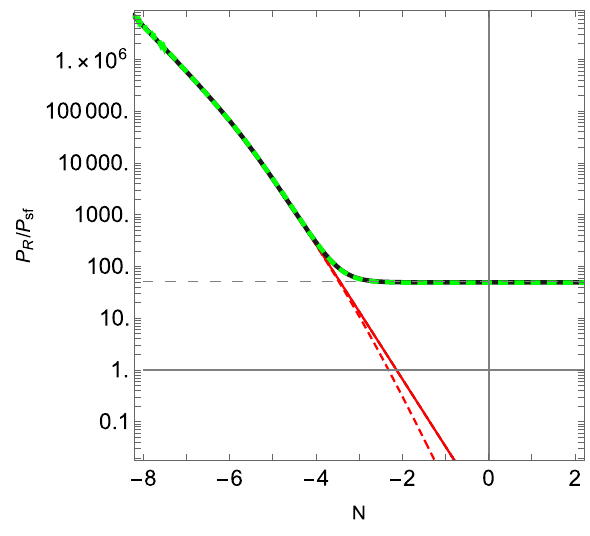
Fig. 4 Numerical calculations in single-field effective theories with modified dispersion relations; model described in Sect. 5.2. Left panel: evolution of the sound speed given by Eq. (6) for initial conditions leading to a freezing adiabatic mode (red solid line) and for initial con- ditions leading to a decaying adiabatic mode (blue dashed lines); of thin dashed lines, one corresponds to the value (22) and the other shows